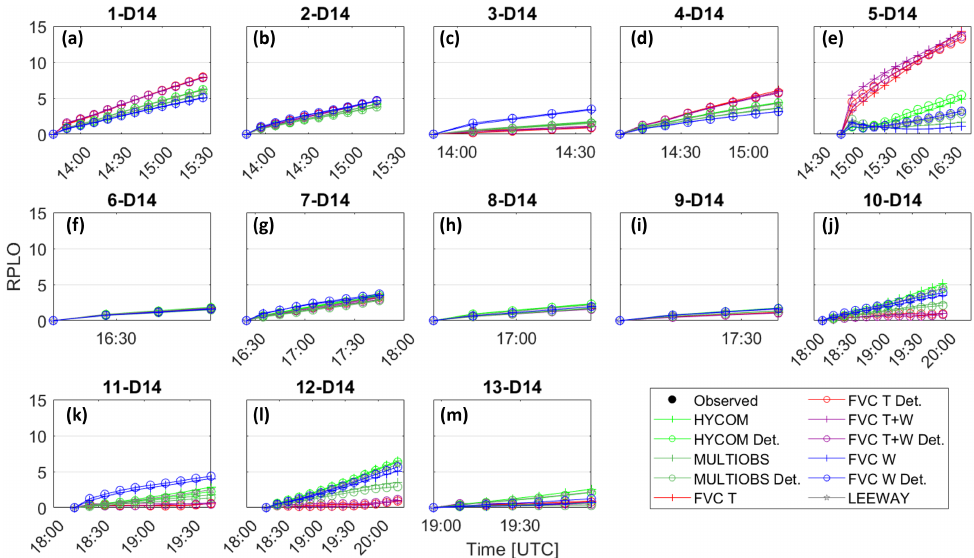
Figure 13. Time evolution of NCLS mod values during 14 September 2011. ( a – m ) Drifter deployments 1–13, respectively, as indicated in Figure 9b. Panel titles indicate drifter deployment number (X- D14, where X is drifter number). FVC = FVCOM; T = Tide; W = Wind; Det. = deterministic (drag force) method.